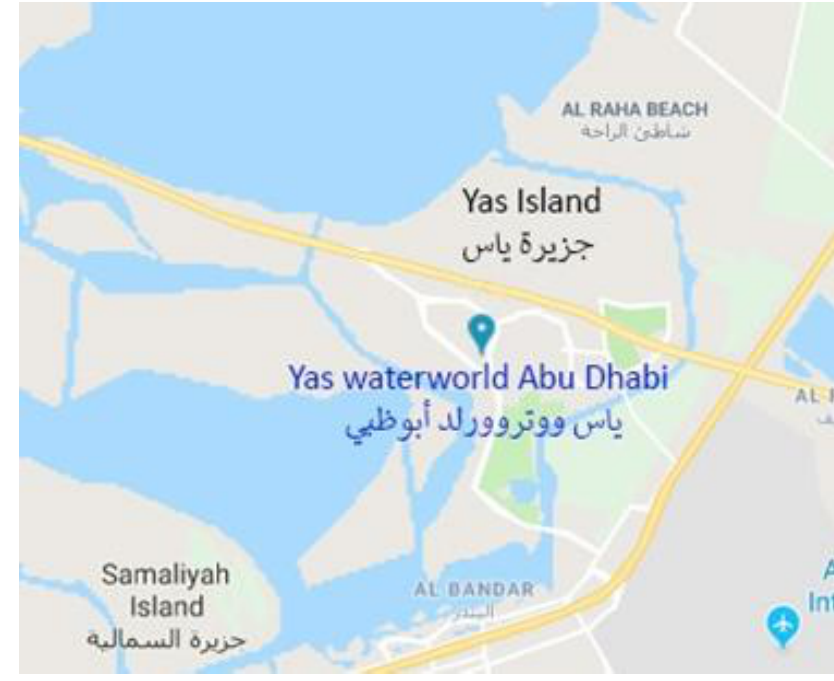
Figure 1. Map of Yas Island .